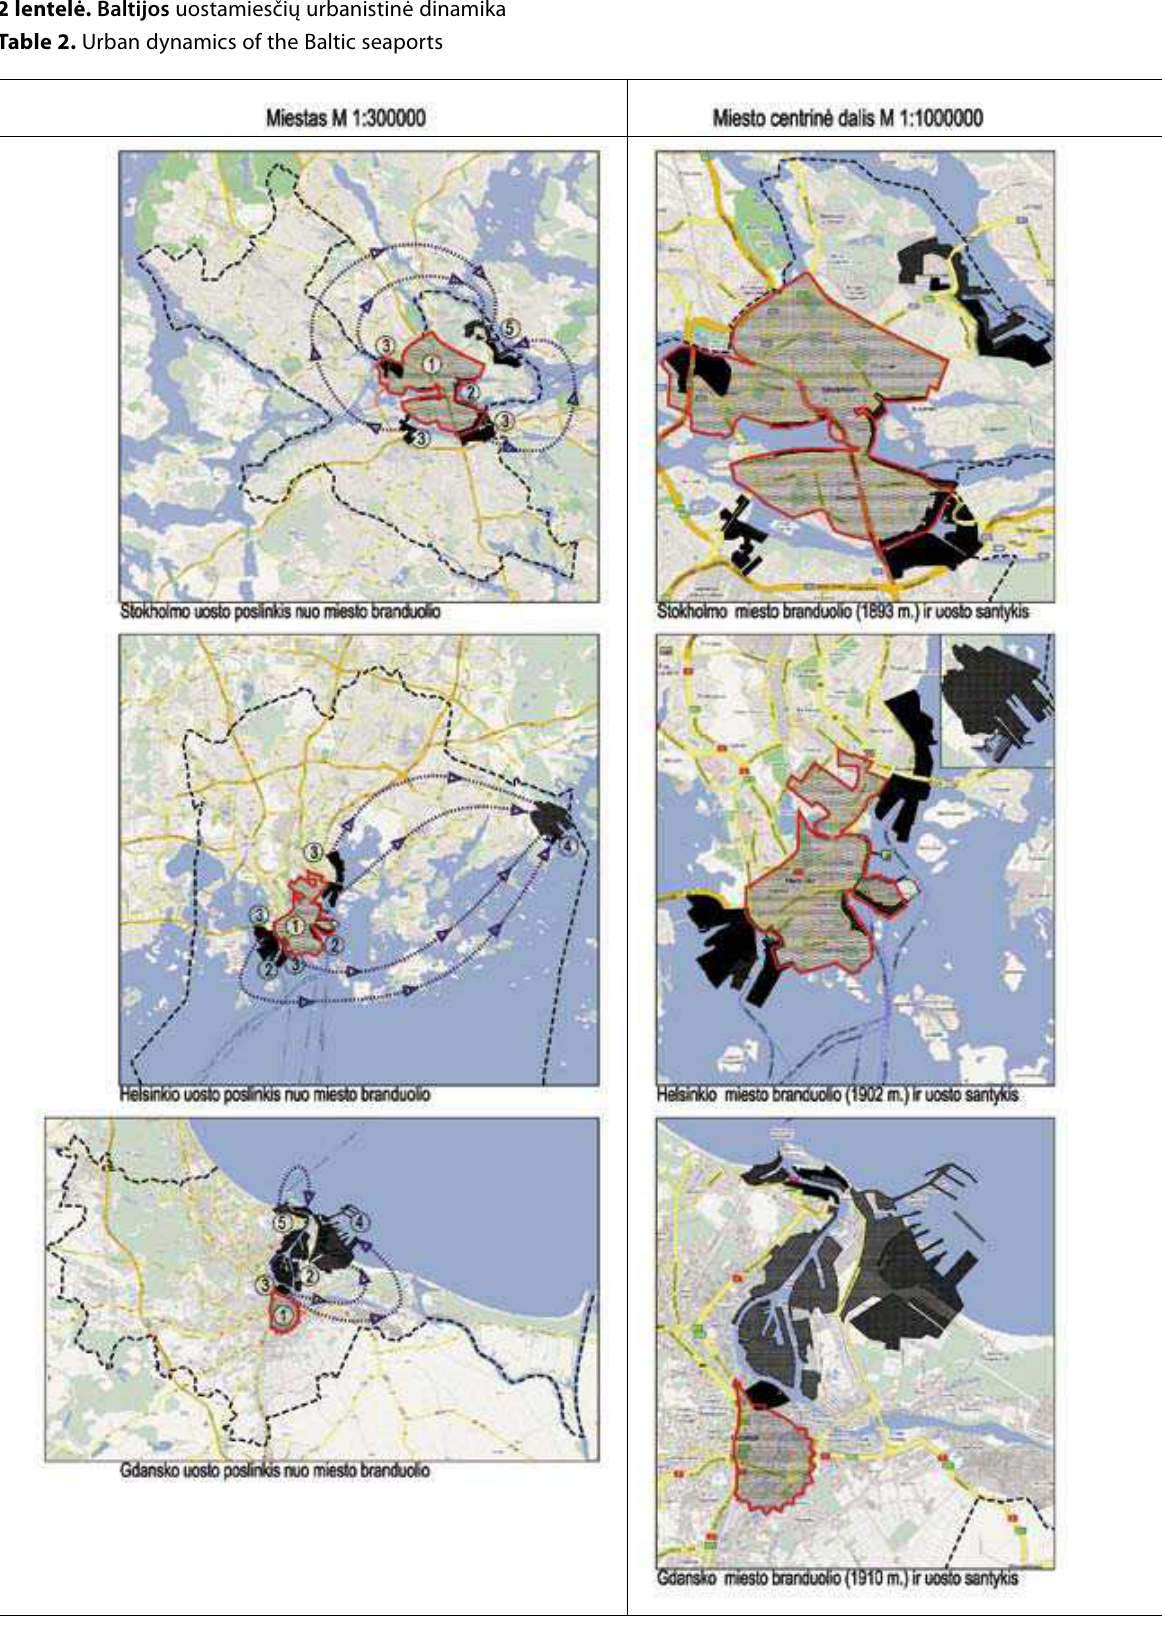
Table 2. Urban dynamics of the baltic